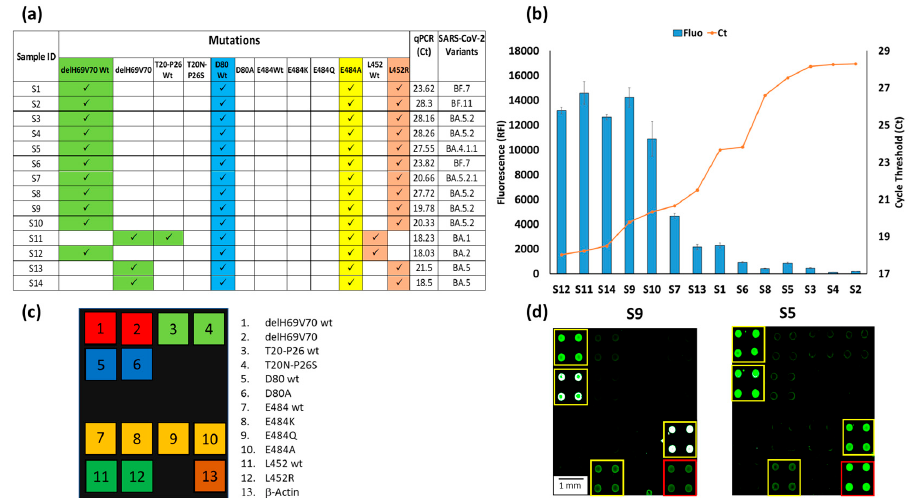
Figure 5. ( a ) Mutations signature of the sample S1-14, the corresponding Ct of the qPCR of the same samples and the identification of the SARS-CoV-2 subvariants based on genome sequencing. ( b ) Plots of the correspondence between the relative fluorescence intensity (blue bars) of the hybridization of the 14 chips with samples S1-14, with the number of Cycle Threshold (Ct) of the corresponding qPCR (red line) of the same 14 samples. The blue bars are the average of the relative fluorescence intensity (RFI) of the 4 spots (2 × 2 subarrays) of the 484A capture probe subarray. The error bars are the standard deviations of the fluorescence intensity of the subarray. ( c ) The spotting schema of the array. ( d ) Example of Cy3 fluorescence image of two silicon chips. Each chip is hybridized with a triplex Cy3-labeled PCR (Amplicon1, 2 and 3) from samples S9 and S5. The yellow squares in the images were used to highlight the spots corresponding to the presence of hybridization. The red square indicates the hybridization of the Amplicon3 ( β -actin). The spots are 400 µ m large with a pitch of 800 µ